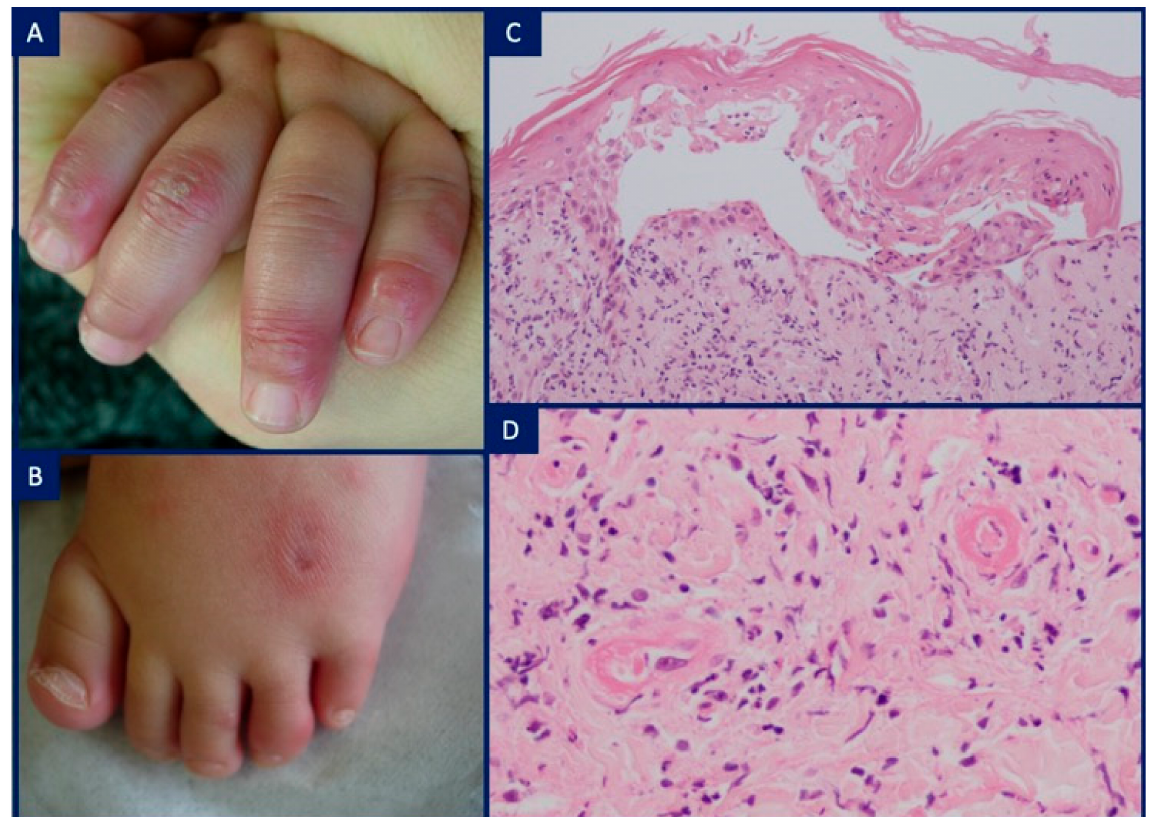
Figure 6. Thrombotic microangiopathy in Aicardi–Gouti è res syndrome: ( A , B ) 1-year-old female with acral necrotic bullous chilblains ( C ) H&E, × 4. Vacuolar interface dermatitis associated with numerous apoptotic keratinocytes, epidermal necrosis and subepidermal bulla. similar to necrotic chilblain lupus erythematosus; ( D ) H&E, × 20. Fibrin deposition in small-sized vessel walls associated with intraluminal